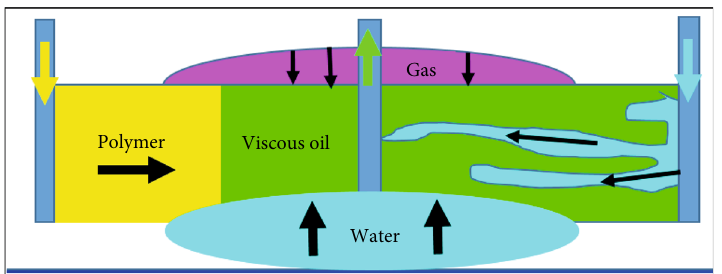
Figure 1: Illustration of sources of pressure to push oil toward a production